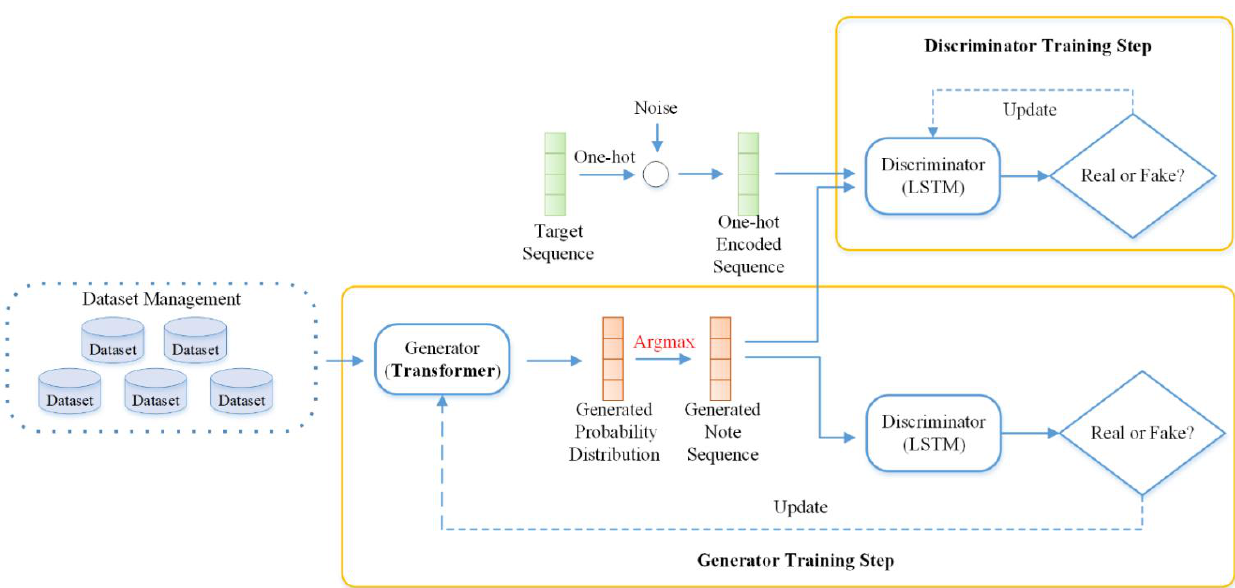
Figure 2. The structure of the music generation system.